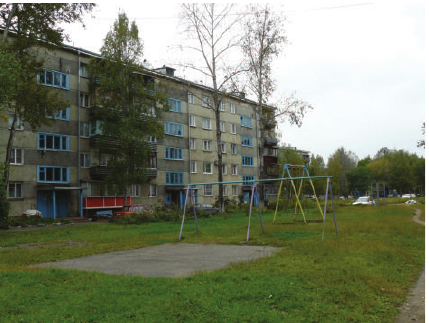
Figure 8: Residential area in Birobidzhan (zone 1).